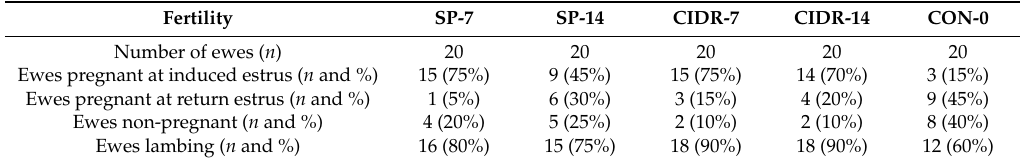
Table 3. Fertility obtained around synchronized and return estrus in sheep treated with one progestagen-impregnated sponge for either 14 (group SP-14; n = 20) or 7 days (group SP-7; n = 20), one progesterone-loaded CIDR for either 14 (group CIDR-14; n = 20) or 7 days (group CIDR-7; n = 20), or no treatment (group CON-0; n =